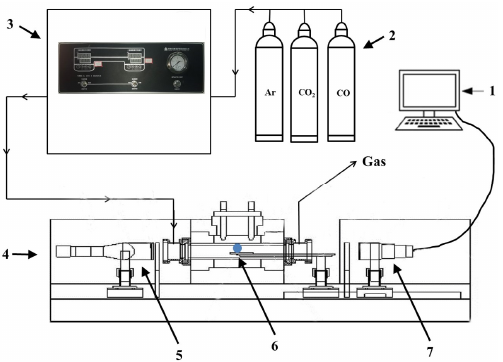
Figure 2. Schematic diagram of the measuring device for the reduction swelling performance of pellets. 1—computer; 2—gas cylinder; 3—flow controller; 4—optical high-temperature deformation analyzer; 5—LED light; 6—pellet sample ; 7—camera.